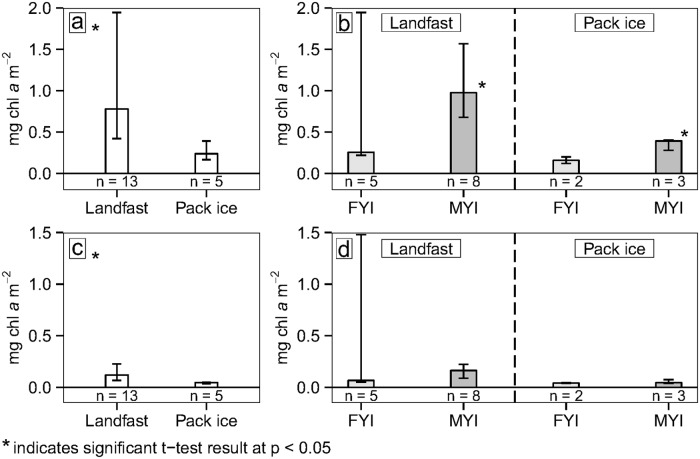
Summary of chl a concentrations comparing landfast ice and pack ice.a) Core-integrated chl a for all cores (MYI and FYI combined); b) core-integrated chl a categorized into FYI (light-gray) and MYI (dark-gray), then by landfast ice (left) and pack ice (right); c) bottom-integrated chl a for all cores; and d) bottom-integrated chl a categorized into FYI (light-gray) and MYI (dark-gray), then by landfast ice (left) and pack ice (right). Bars show median values with error bars delineating the 25 and 75 percentiles.